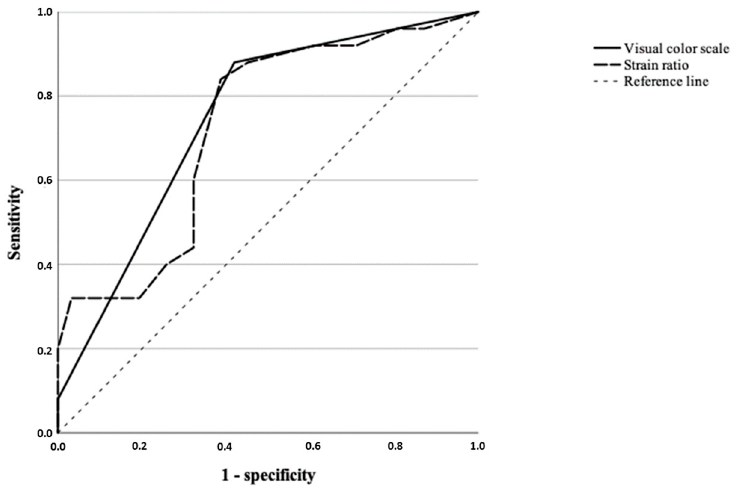
Figure 4. Receiver ‐ operating characteristic curve for the strain ratio (semiquantitative analysis) tak ‐ ing intratumoral fibrosis as the reference ( p = 0.03).